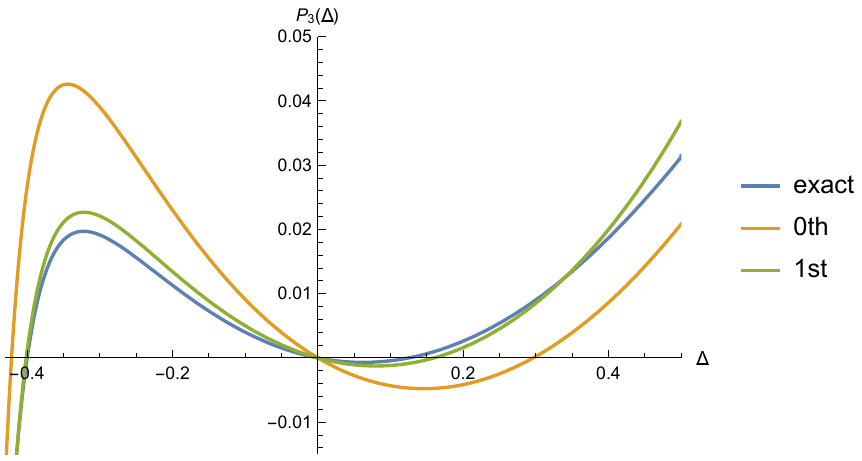
Figure 1 . The exact values (blue) of the OPE coe(cid:14)cient P 3 ((cid:1)) as a function of the scaling dimen- sion (cid:1) of (cid:30) 1 ; 2 and its estimates in the zeroth (orange) and the (cid:12)rst (green) order approximations. The qualitative behavior of the (cid:12)rst order estimate is close to the exact function. The Lee-Yang root of the (cid:12)rst order estimate is rather